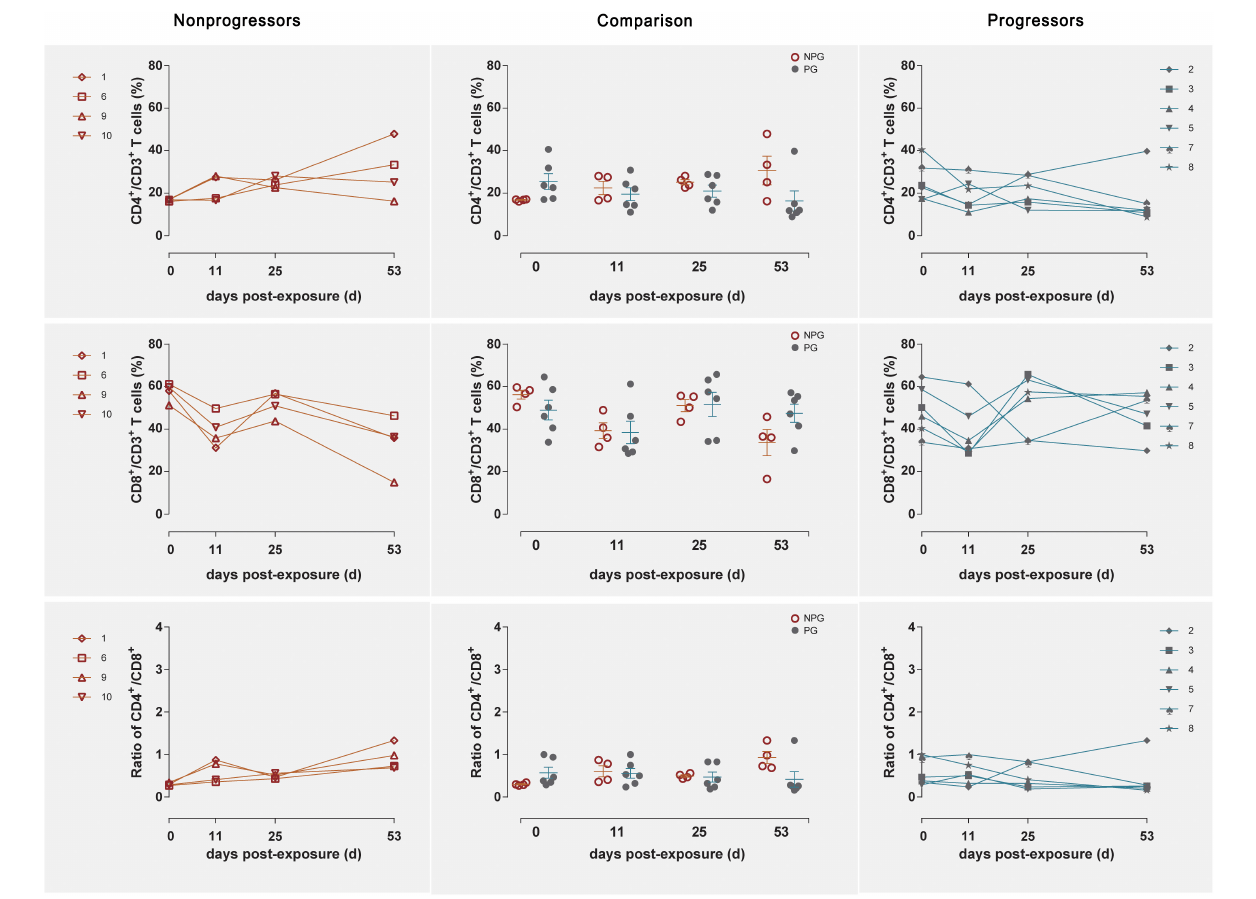
FIGURE 4 | Changes in T lymphocytes among LPMCs in non-progressive and progressive monkeys. The CD4 + T cell percentages, CD8 + T cell percentages, and CD4 + /CD8 + ratios were measured in LPMCs obtained at four time points in four non-progressive monkeys and six progressive monkeys. No significant differences were found between the two subgroups at any time point, indicating that no notable T cell changes occurred in LPMCs from ten ChRhs subjected to repetitive SIV mucosal exposure (unpaired t -test, Welch’s correction, P >